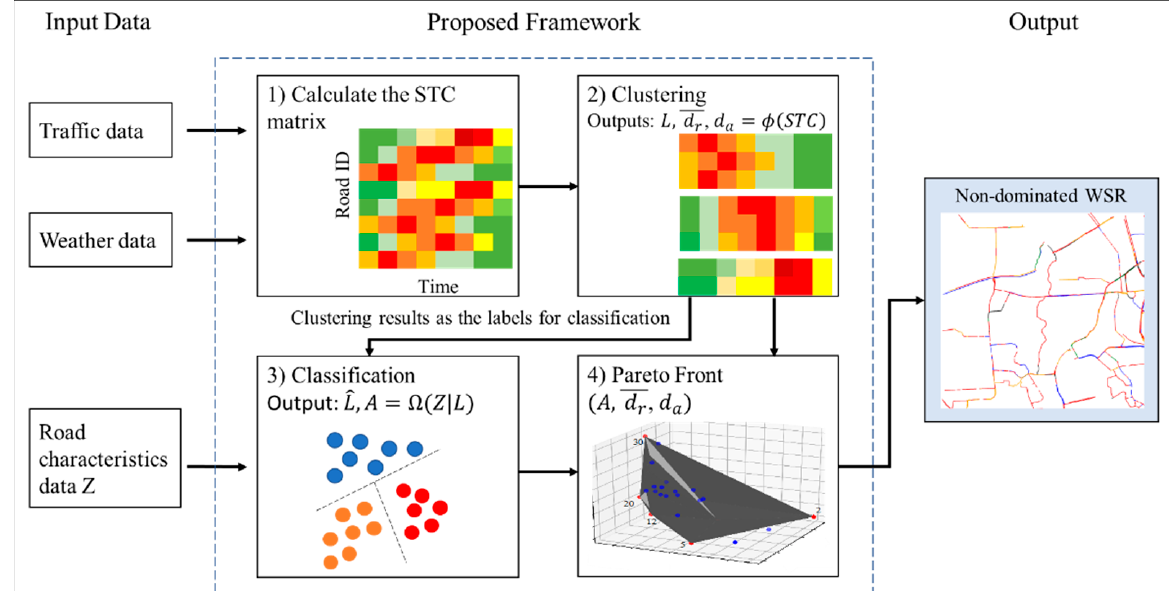
Figure 4. The proposed framework for weather-sensitive roads (WSR) analysis.